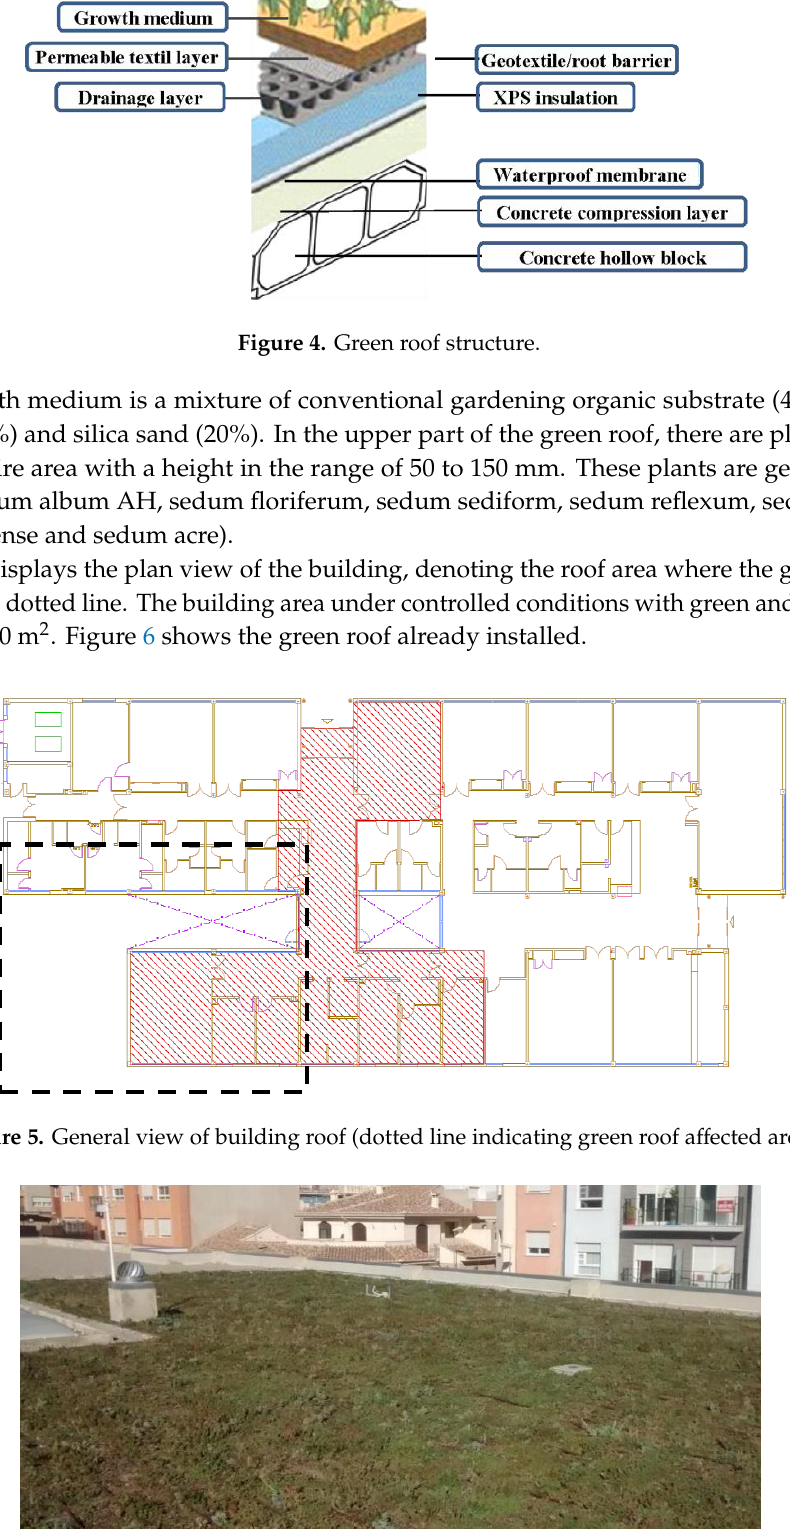
Figure 6. General view of greenroof.